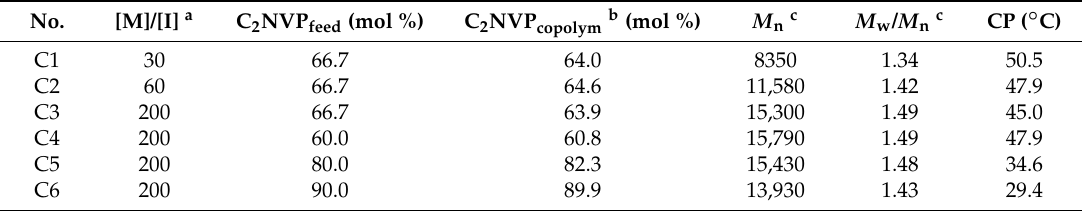
Table 1. Characterization of P(C 2 NVP- co -NVP) copolymers (C1–C6).